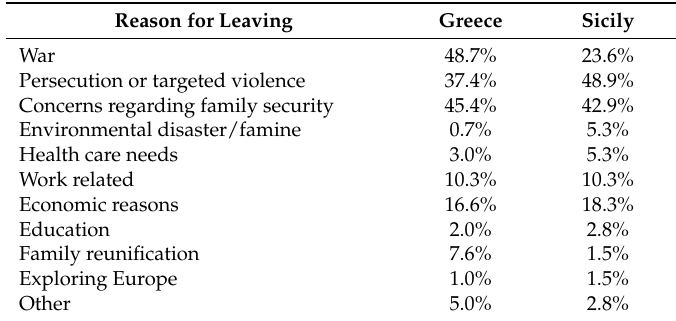
Table 3. Why did you leave your last country of residence? (% within country) (respondents could select up to three